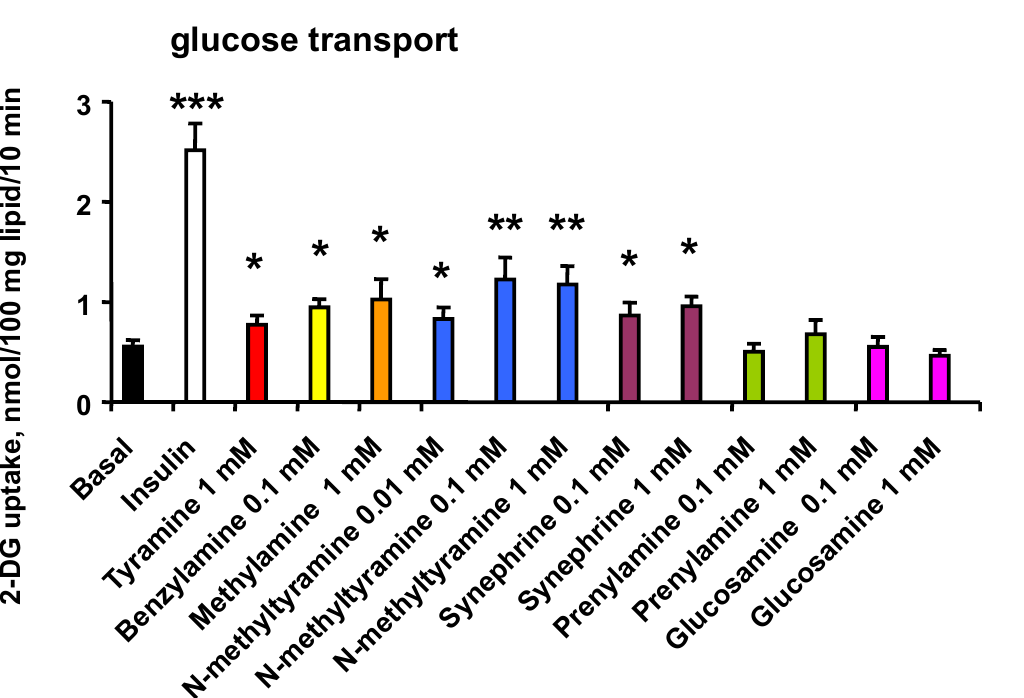
Figure 2. Activation of glucose transport in human adipocytes by insulin and several -but not all- tested amines. The uptake of 2-deoxyglucose (2-DG) was assessed on 10 min after 45-min incubation of human subcutaneous adipocytes without (basal) or with 100 nM insulin (open column), or with the indicated concentrations of: tyramine (red), benzylamine (yellow), methylamine (orange), NMT (blue columns), synephrine (purple columns), prenylamine (green columns) or glucosamine (pink columns). Each column is the mean ± SEM of 8 determinations (mean BMI of subjects was: 24.6 ± 1.3, age range: 34 – 56 year). 2-DG uptake was expressed as nmoles of hexose transported/100 mg cell lipids/10 min. The mean amount of cell lipids per assay was 20 ± 2 mg. Significant influence was evidenced by ANOVA followed by Dunnett ’ s test by difference from basal at: * p < 0.05; ** p < 0.01; *** p < 0.001.